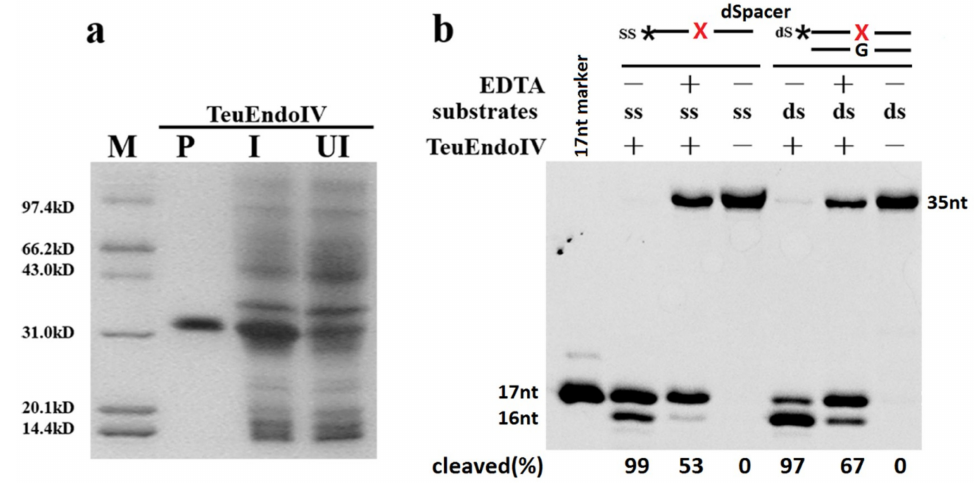
Figure 1. AP endonuclease activity of TeuendoIV. ( a ) 15% SDS-PAGE analysis of recombinant TeuendoIV. Lane M, molecular weight marker; lane P, purified recombinant TeuendoIV; lanes I and UI denote induced and uninduced E. coli total proteins. ( b ) Cleavage of ssDNA and dsDNA carrying a synthetic AP site, dSpacer, by TeuendoIV. The reaction mixtures contained 20 mM Tris-HCl pH 7.6, 100 mM NaCl, 100 nM AP site-containing dsDNA (AP/G) or ssDNA, and 5 nM TeuendoIV and